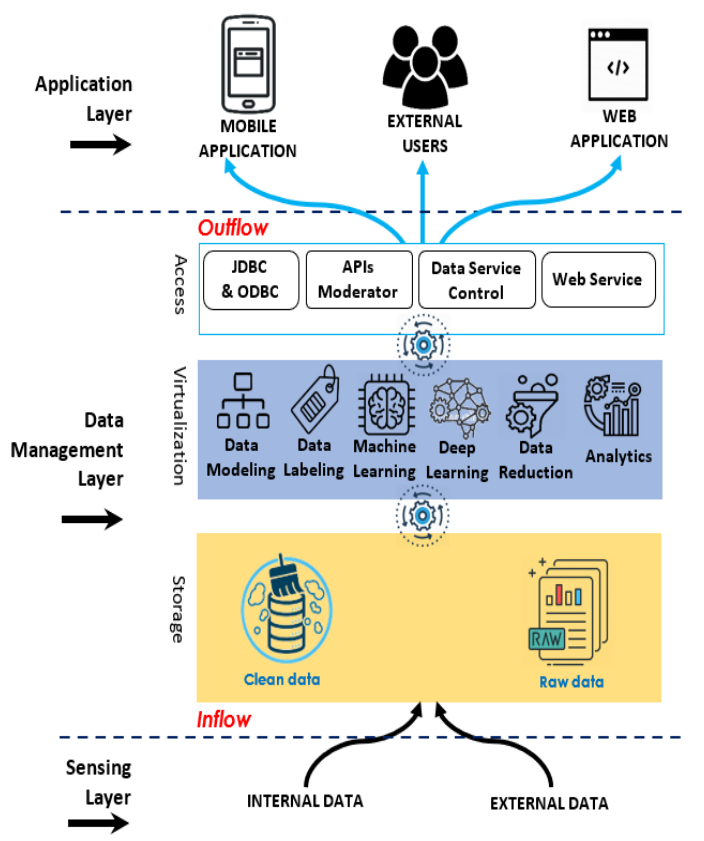
Figure 3. Proposed data-driven architecture